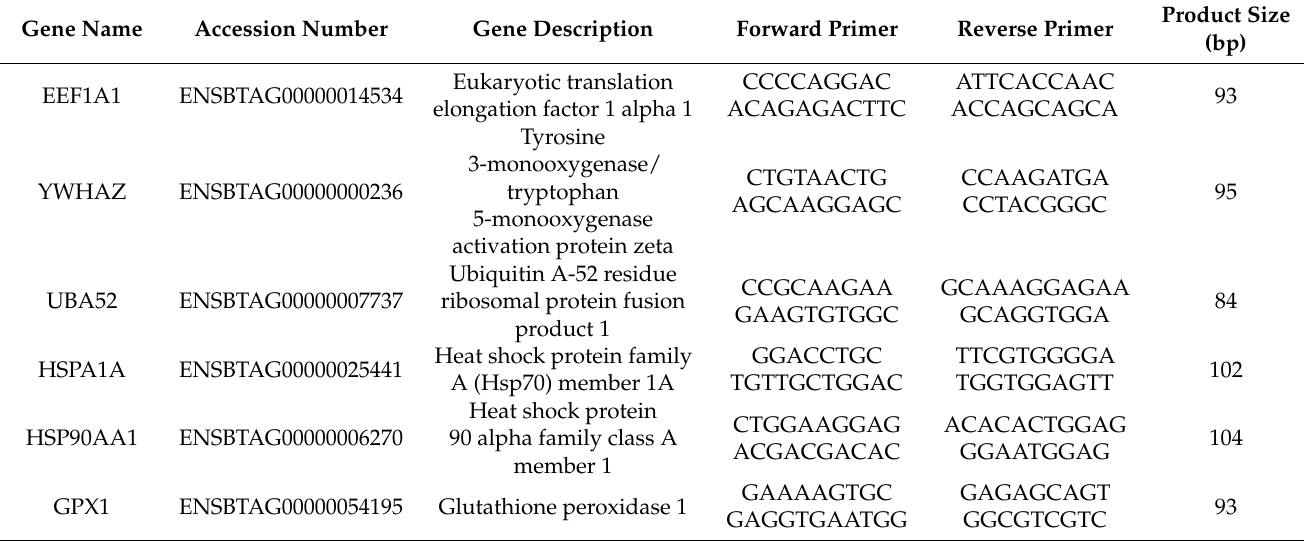
Table 1. Primer information: sequence, size of the amplified fragments of transcripts and accession